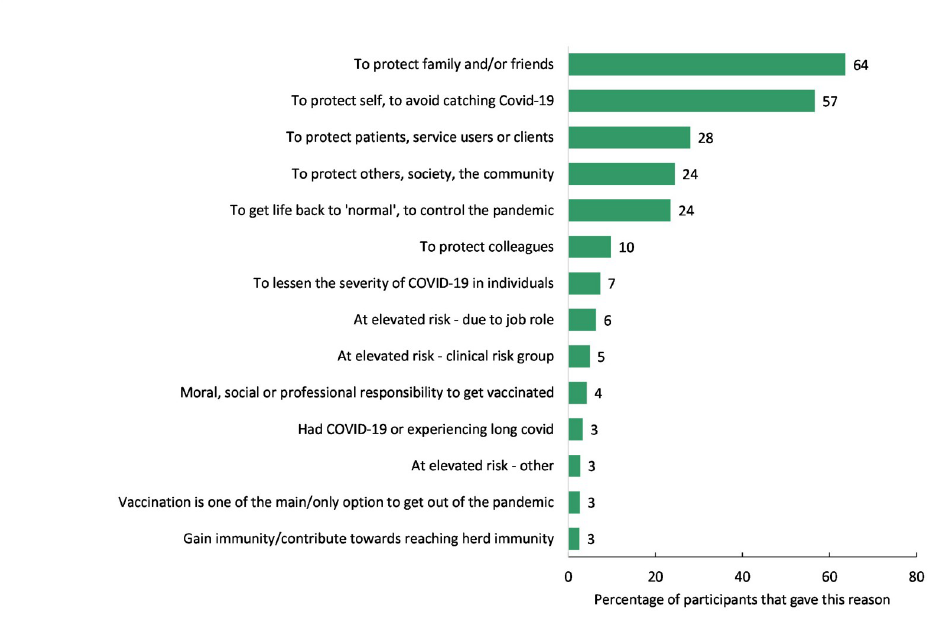
Fig 1. Reasons for